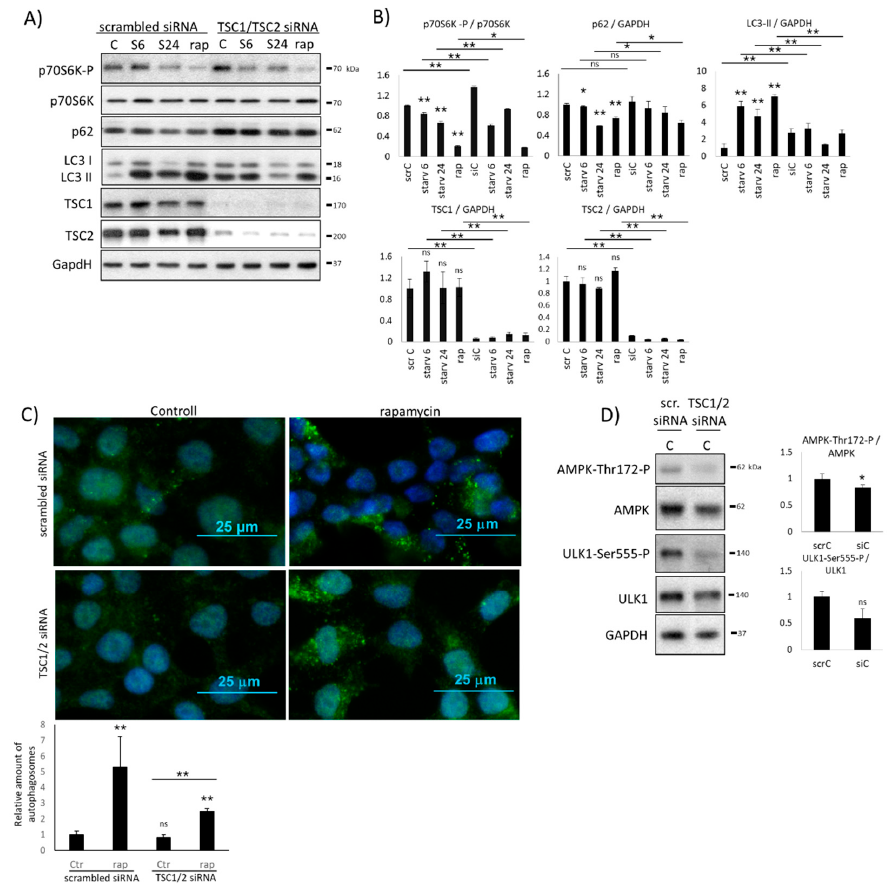
Figure 3. The effect of mTOR hyper-activation (by TSC1/2 silencing) on AMPK level under various stress events. HEK293T cells were starved (for 6h or 24h) or treated with rapamycin (rap – rapamycin —100 nM, 2 h) without/with silencing of TSC1/2 by siRNA. ( A ) The markers of autophagy (LC3, p62), mTOR (p70S6K-P), TSC1, and TSC2 were followed by immunoblotting. GAPDH was used as